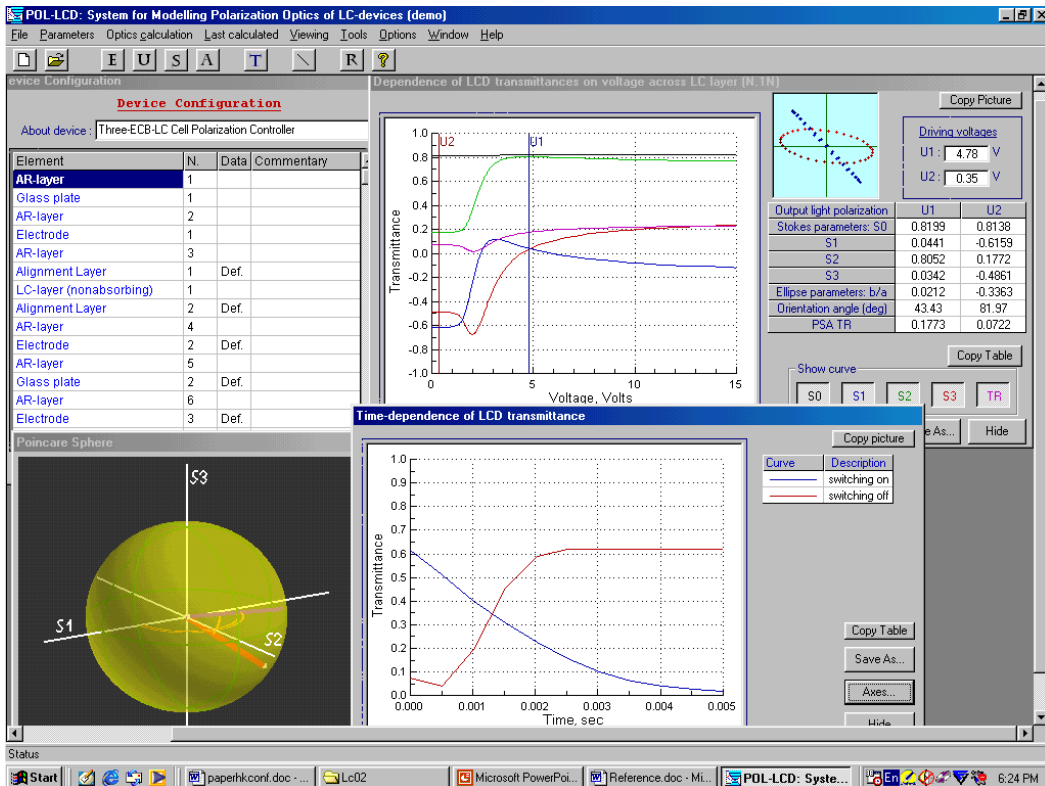
Figure 7. The example of a polarization controller, based on three subsequently placed LC cells, developed and optimized using our new software POL (polarization)-LCD